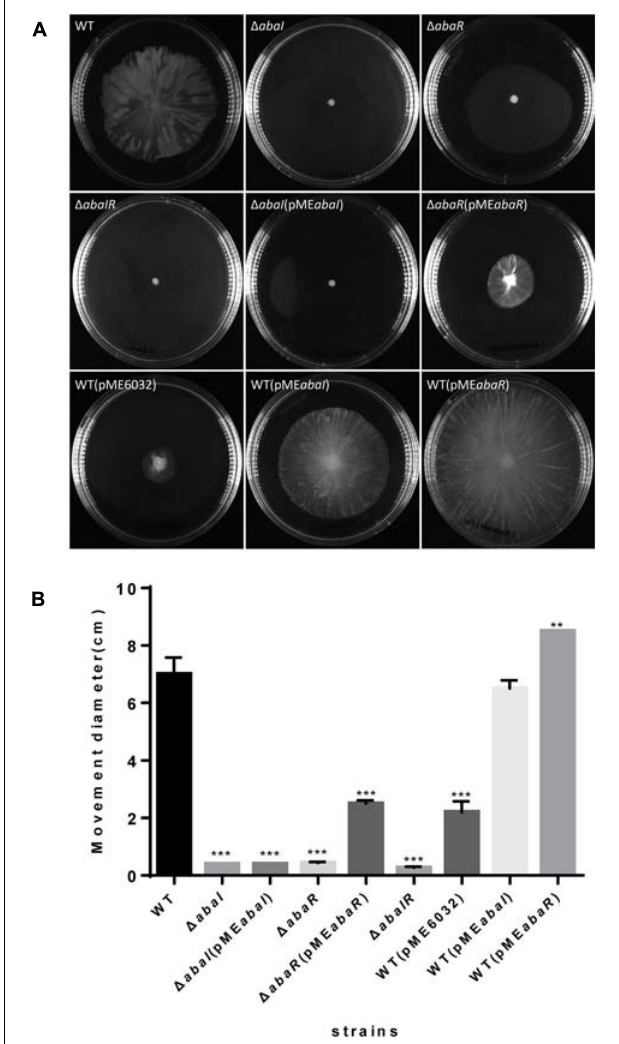
FIGURE 3 | (A) Wild type and mutants were inoculated on the surface of a semisolid agarose plate (0.3%) and incubated for 12–14 h at 30 ◦ C. abaI , abaR , and abaIR mutant strains demonstrated defects in surface-associated motility compared to the parental strain. (B) The distance migrated (diameter) is shown for each strain, and error bars represent SD for three biological replicates. ** P < 0.005; *** P <